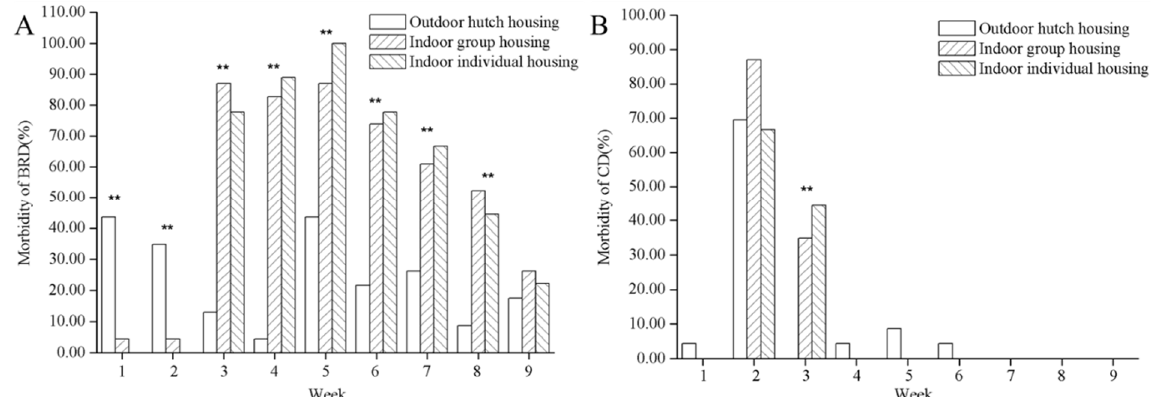
Figure 3. Morbidities as a result of ( A ) bovine respiratory disease (BRD) and ( B ) diarrhea among calves. ** Means within the same week of calves were significantly different at p < 0.05 between the three rearing systems. Table 4. Immunity parameter values for the calves in the trial.